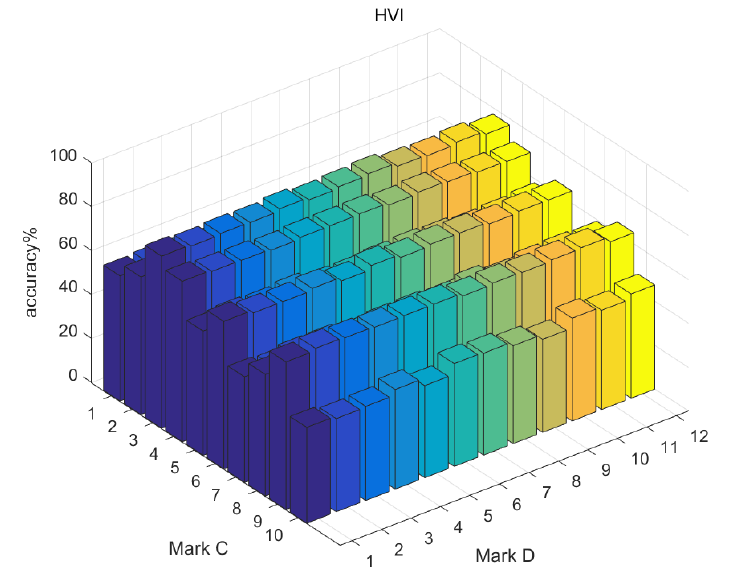
Figure 12. Evaluation of